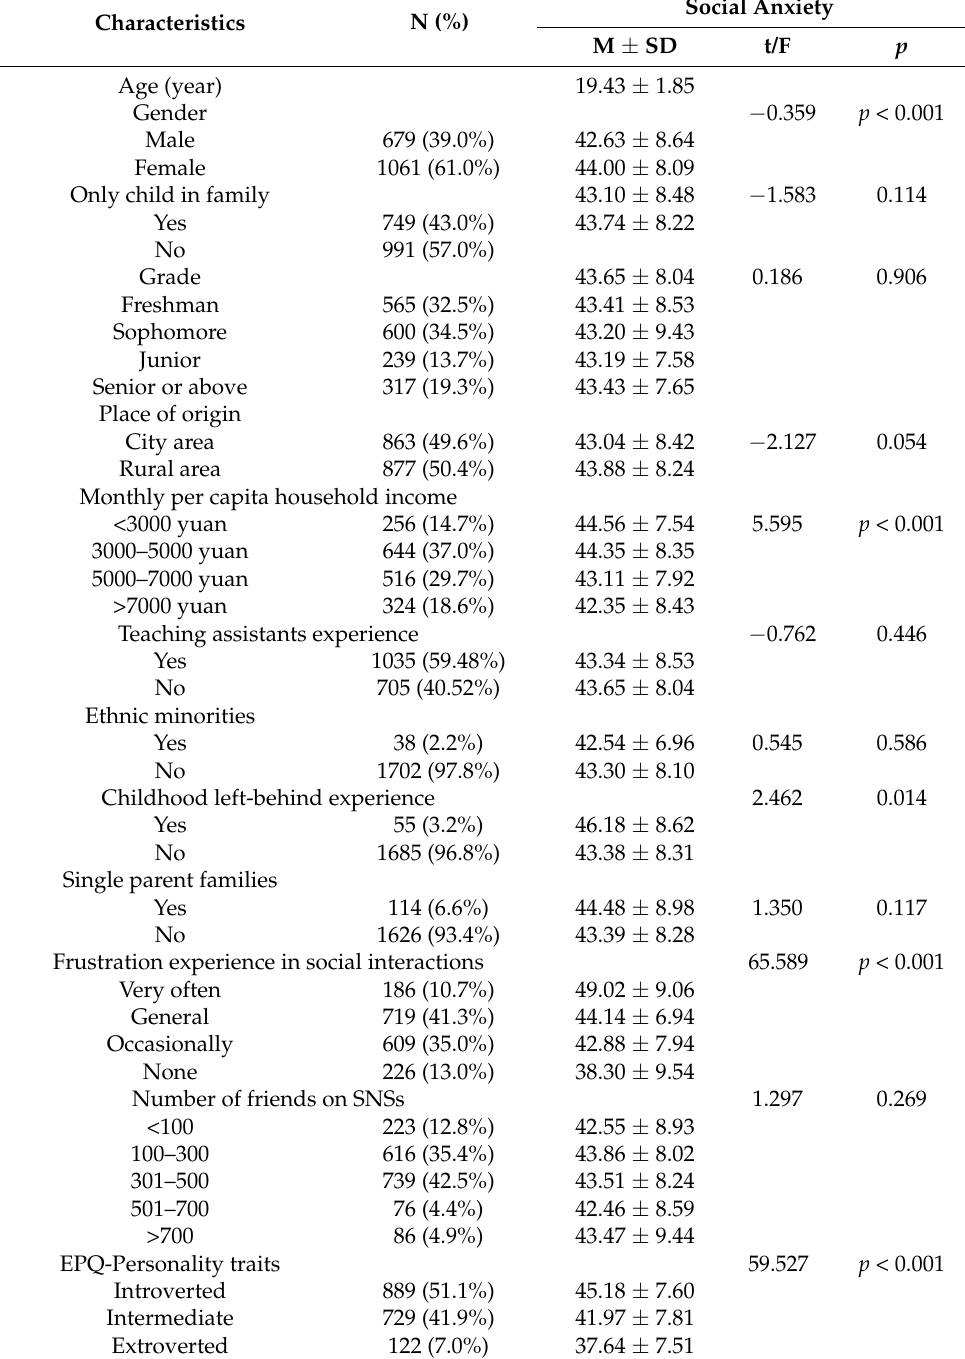
Table 1. Participants’ sociodemographic characteristics (N =